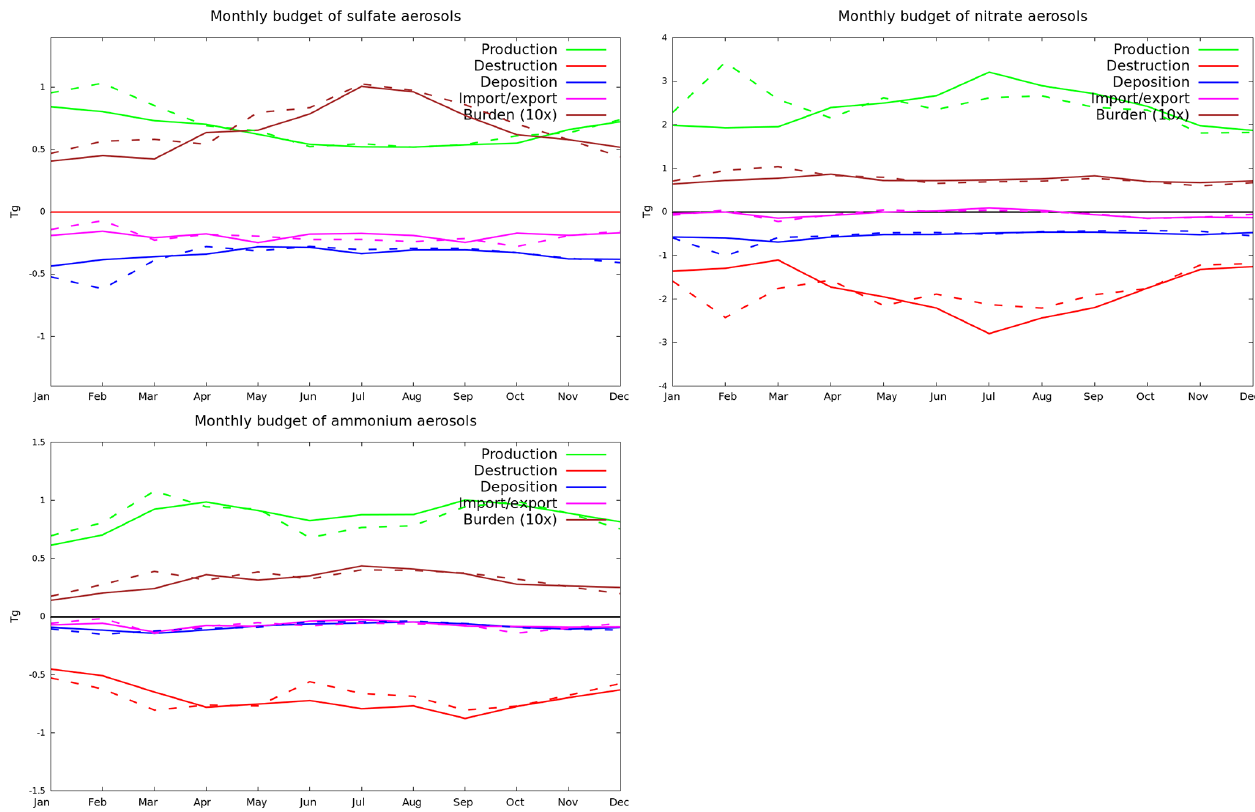
Figure 8. Monthly budget for the total mass of secondary aerosols for the years 2012 (dashed lines) and 2013 (solid line). The green lines correspond to the emissions, the red ones to the chemical loss, the blue ones to deposition, the pink ones to the import or export part and the brown ones the